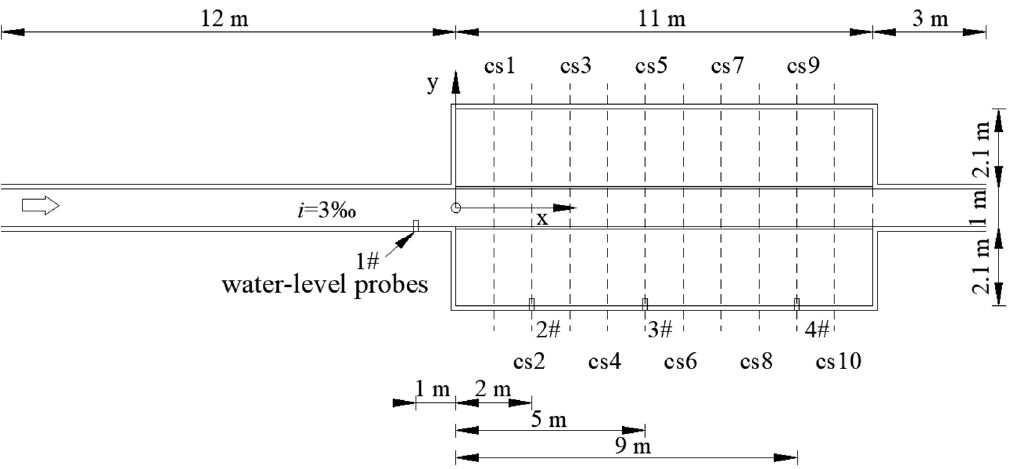
Figure 2. A photo of the testing flume.